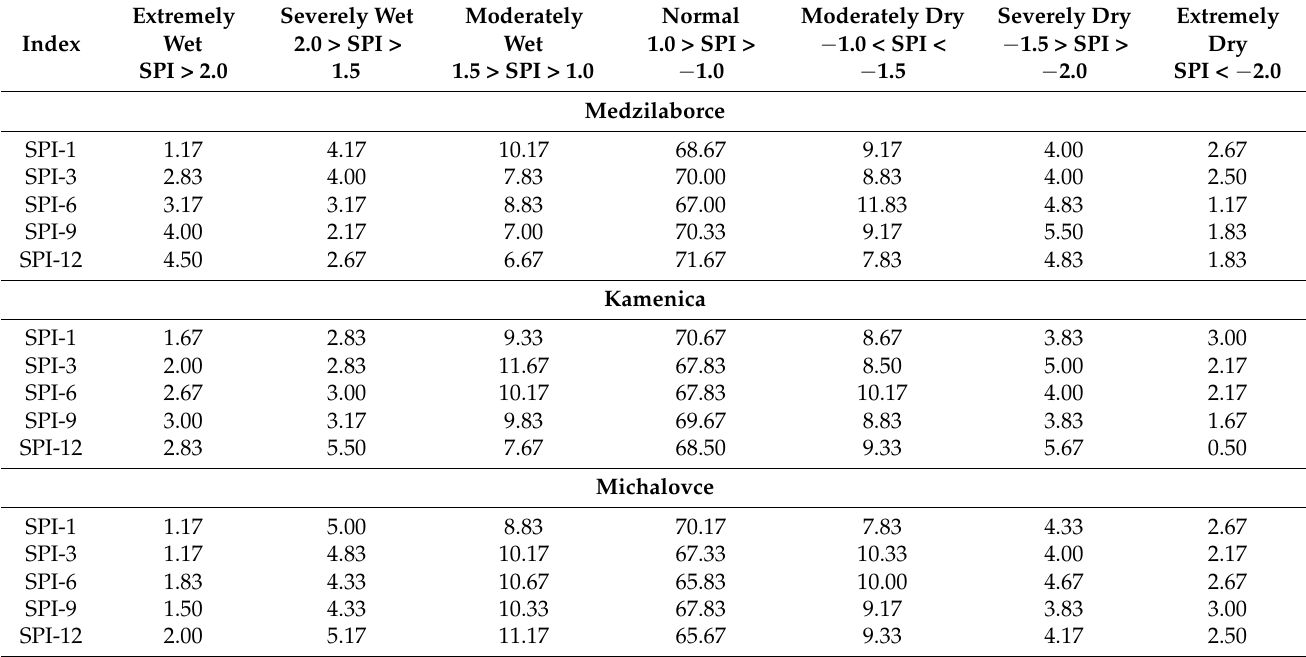
Table 7. SPI parameters over various time scales for Medzilaborce, Kamenica, and Michalovce hydrological stations in the period 1970–2019.